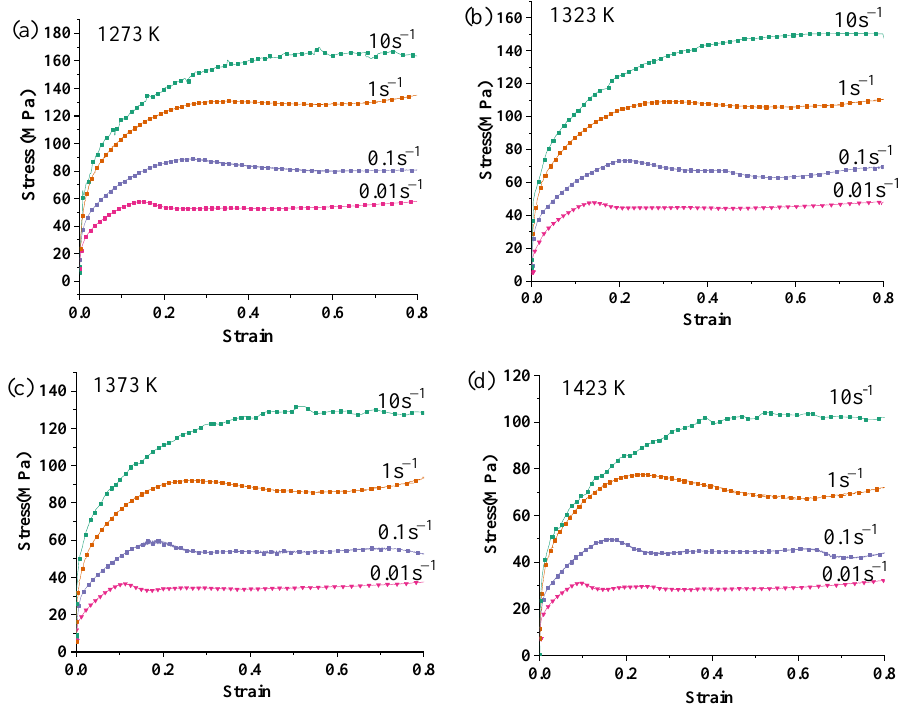
Figure 2. Experimental stress–strain curve of 30CrMoA steel under high-temperature compression: ( a ) T = 1273 K, ( b ) T = 1323 K, ( c ) T = 1373 K, and ( d ) T = 1423 K.